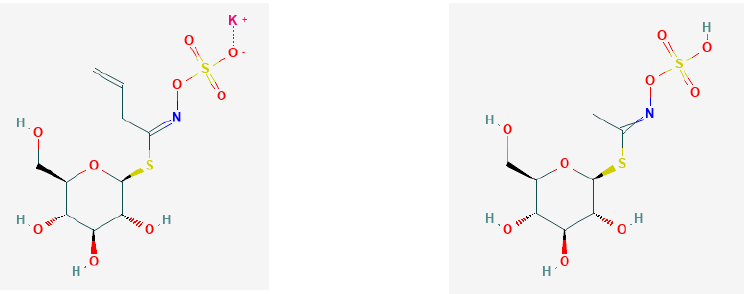
Figure 2. Chemical structures of glucocapparin (PubChem Identifier: CID 5281133; https://pubchem. ncbi.nlm.nih.gov/compound/21600408) and sinigrin (PubChem Identifier CID 23682211; https: //pubchem.ncbi.nlm.nih.gov/compound/23682211), respectively, from PubChem